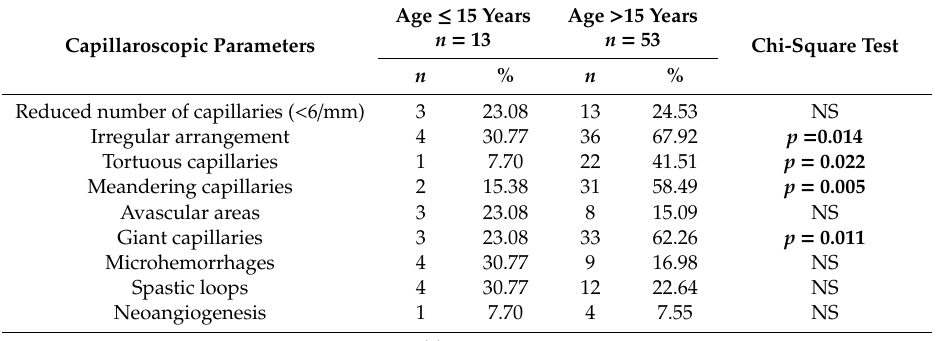
Table 3. Qualitative capillary parameters in the group of patients with RP in relation to age.